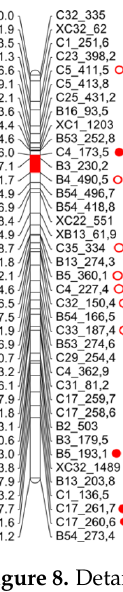
Figure 8. Detail of the LG3 obtained after combining maternal and paternal LG3s. The circles indicate the markers associated with %AES, the open circles indicate the markers found in the F 1-C , and the filled red circles are those found in the F 1-Z . The red color on the LG marks a region delimited by a marker detected in F 1-C and others detected in F 1-Z.